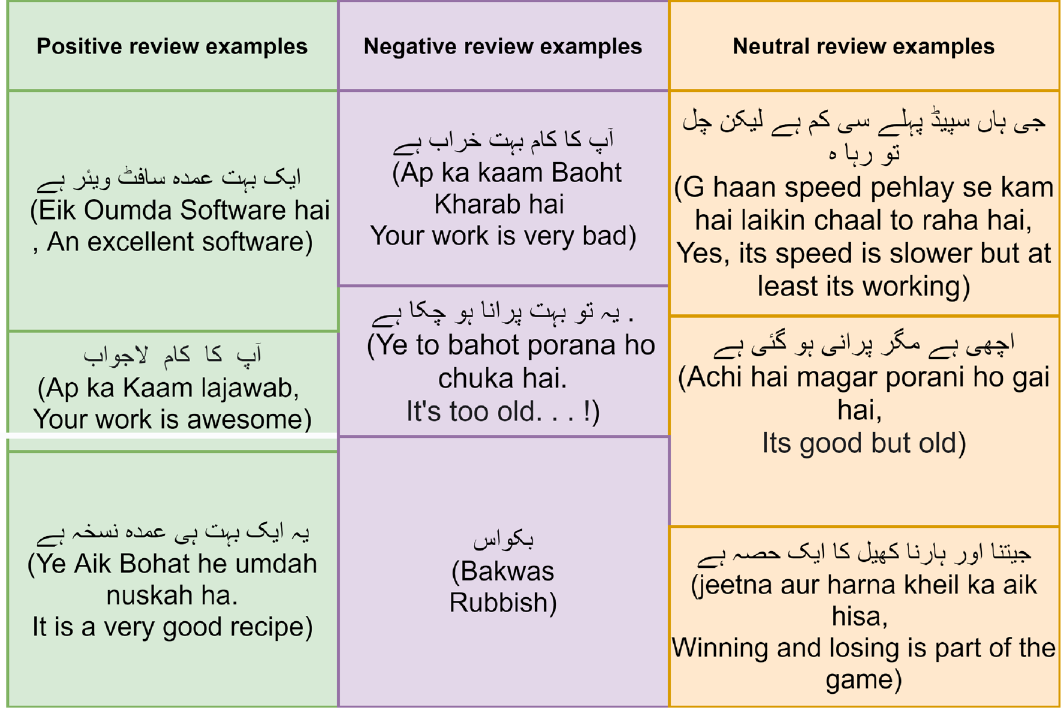
Figure 1. Examples of customer reviews label as neutral, positive and